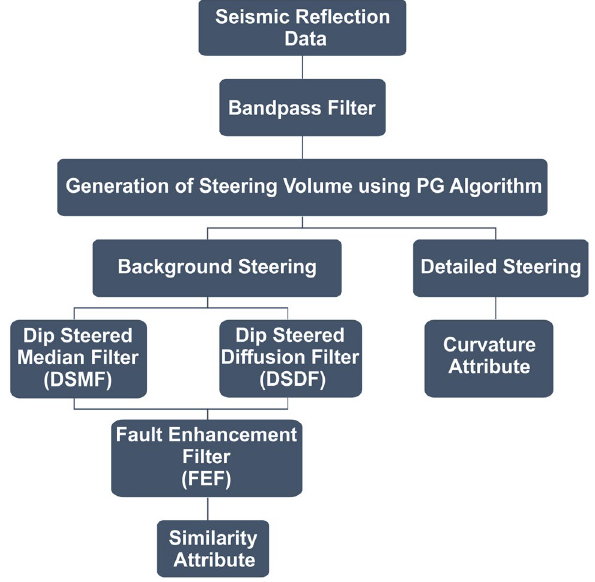
Fig. 4 A detailed workflow chart demonstrating the Seismic data con- ditioning procedures used to sharply delineate major and minor